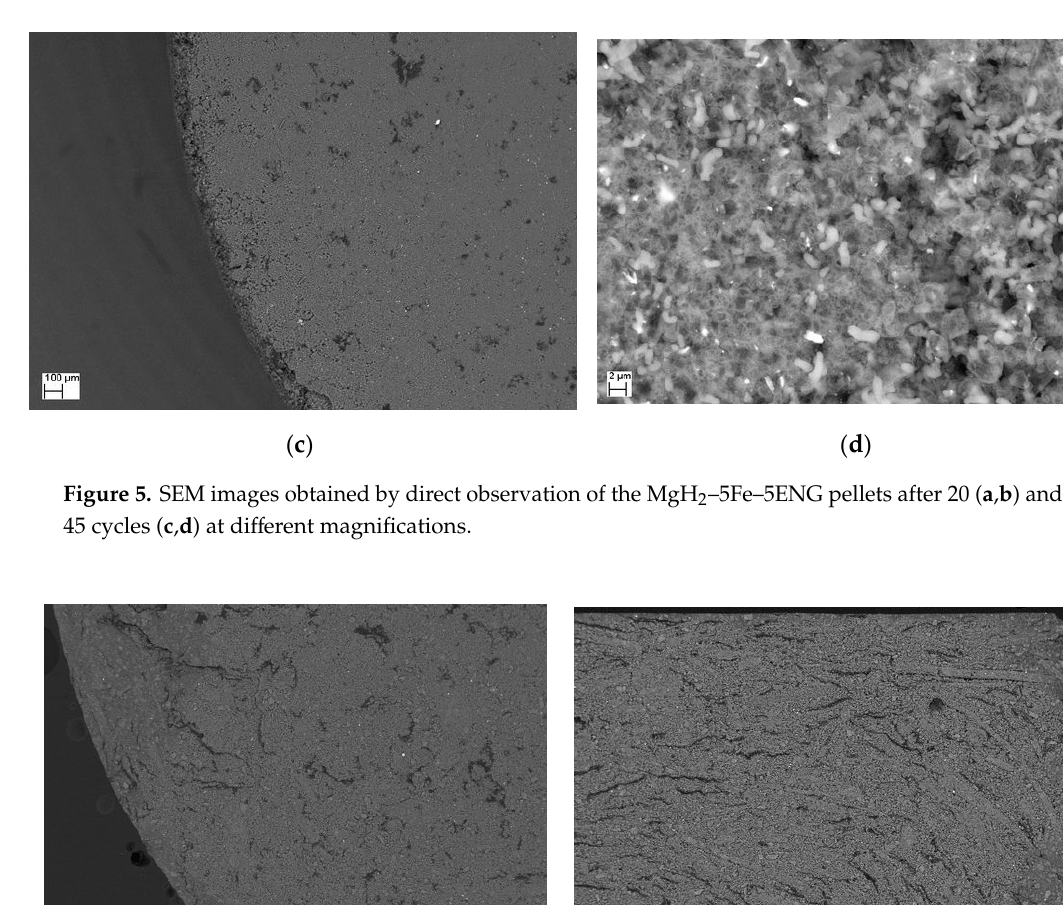
Figure 6. ( a ) Radial and ( b ) axial cross-sections of MgH 2 –5Fe–5ENG compacted powder after